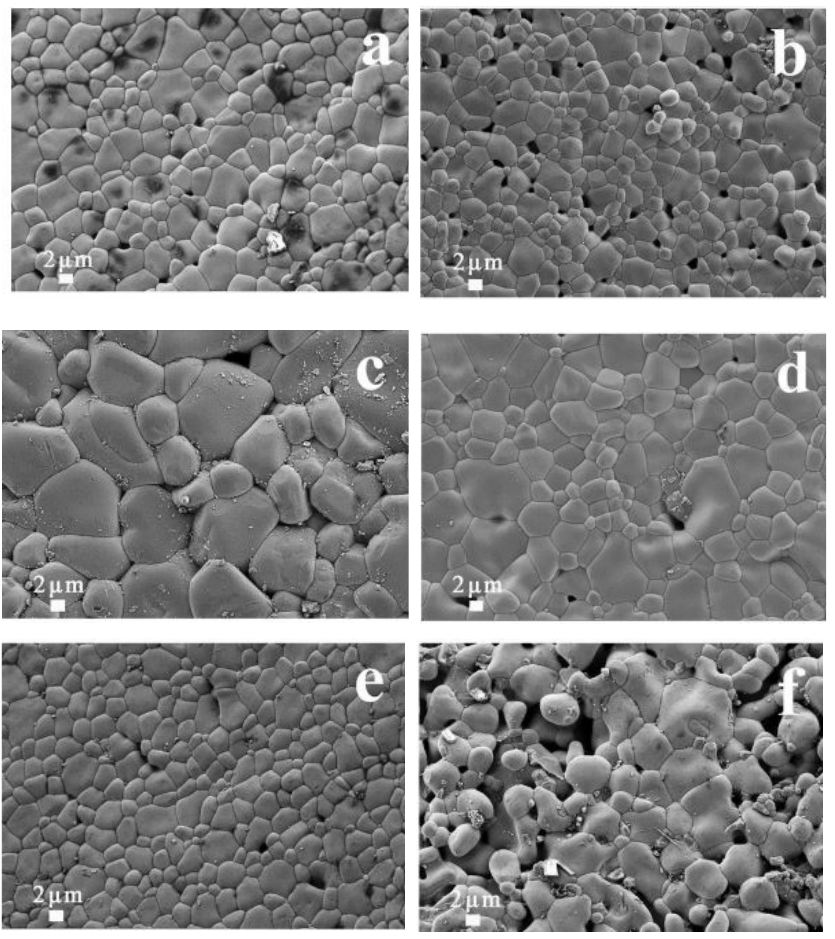
Figure 6. SEM images of CCTO powders obtained by calcination at ( a ) 700 °C, ( b ) 750 °C, ( c ) 800 °C, ( d ) 850 °C, ( e) 900 °C and ( f ) 1000 °C by Wang et.al [40].